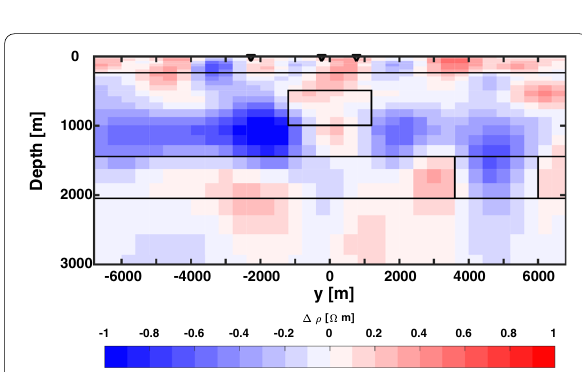
Fig. 26 Cross section of the difference in model parameters (resistivity in the base 10 logarithmic scale) between the synthetic PTATAN inversion results obtained with and without near‑surface distorters. Artifacts or false anomalies are found not only near the surface but also at depth